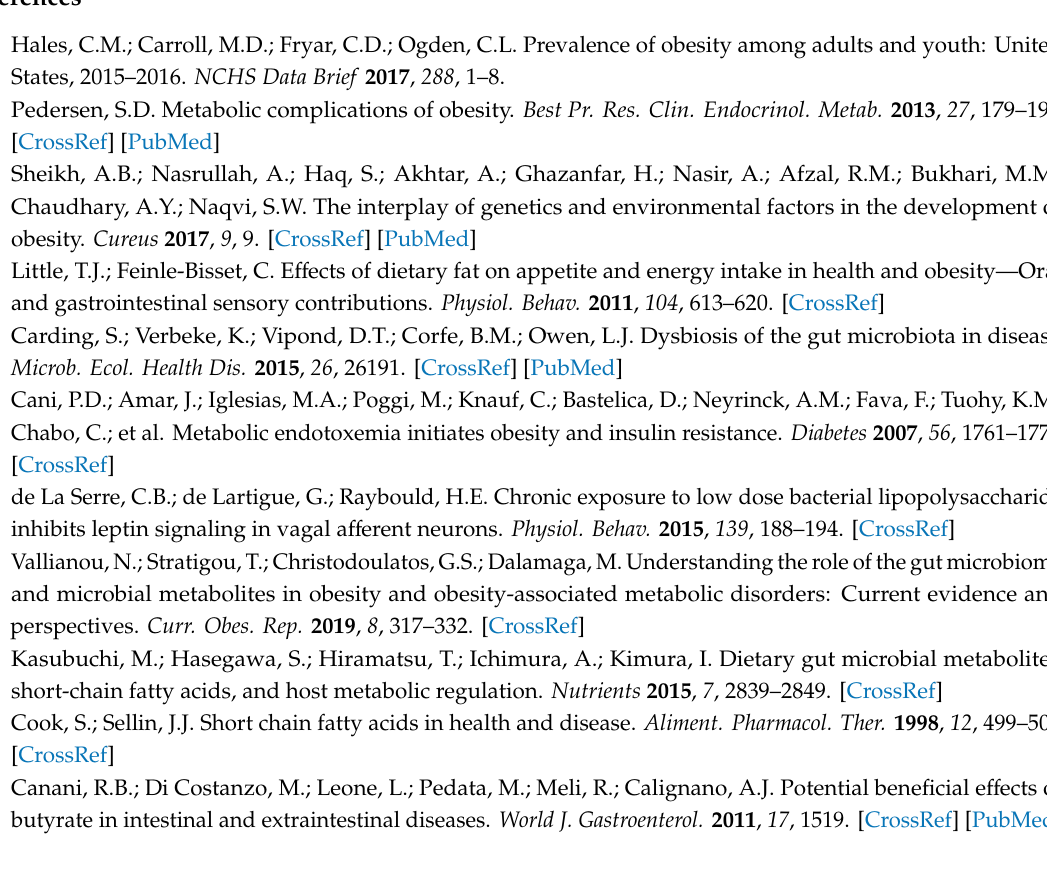
Supplemental Figure S1: Cladogram generated from LEfSe analysis showing the most di ff erentially abundant taxa enriched in microbiota. Supplemental Table S1: Beta diversity Metrics: ANOSIM pairwise comparisons by diet, treatment, and cohort. Supplemental Table S2: Di ff erentially abundant fecal microbiota genera between cohorts. Supplemental Table S3: E ff ect of diet, treatment, and cohort on levels of bacterial metabolites in feces. Supplemental Table S4: Di ff erentially abundant PICRUSt2 identified Metacyc pathways between